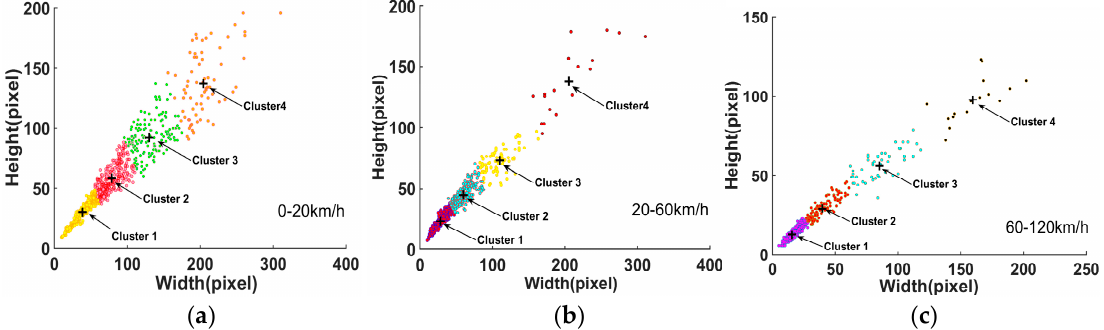
Figure 6. Clustering results of vehicle sizes: ( a ) at 0–20 km/h; ( b ) at 20–60 km/h; and ( c ) at 60–120 km/h.